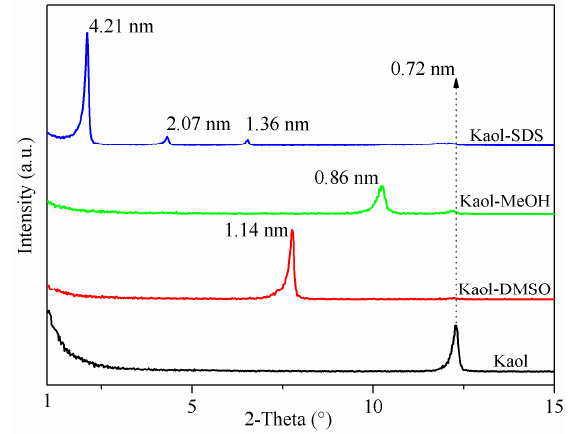
Figure 1. XRD patterns of Kaol and the intercalated Kaol products.